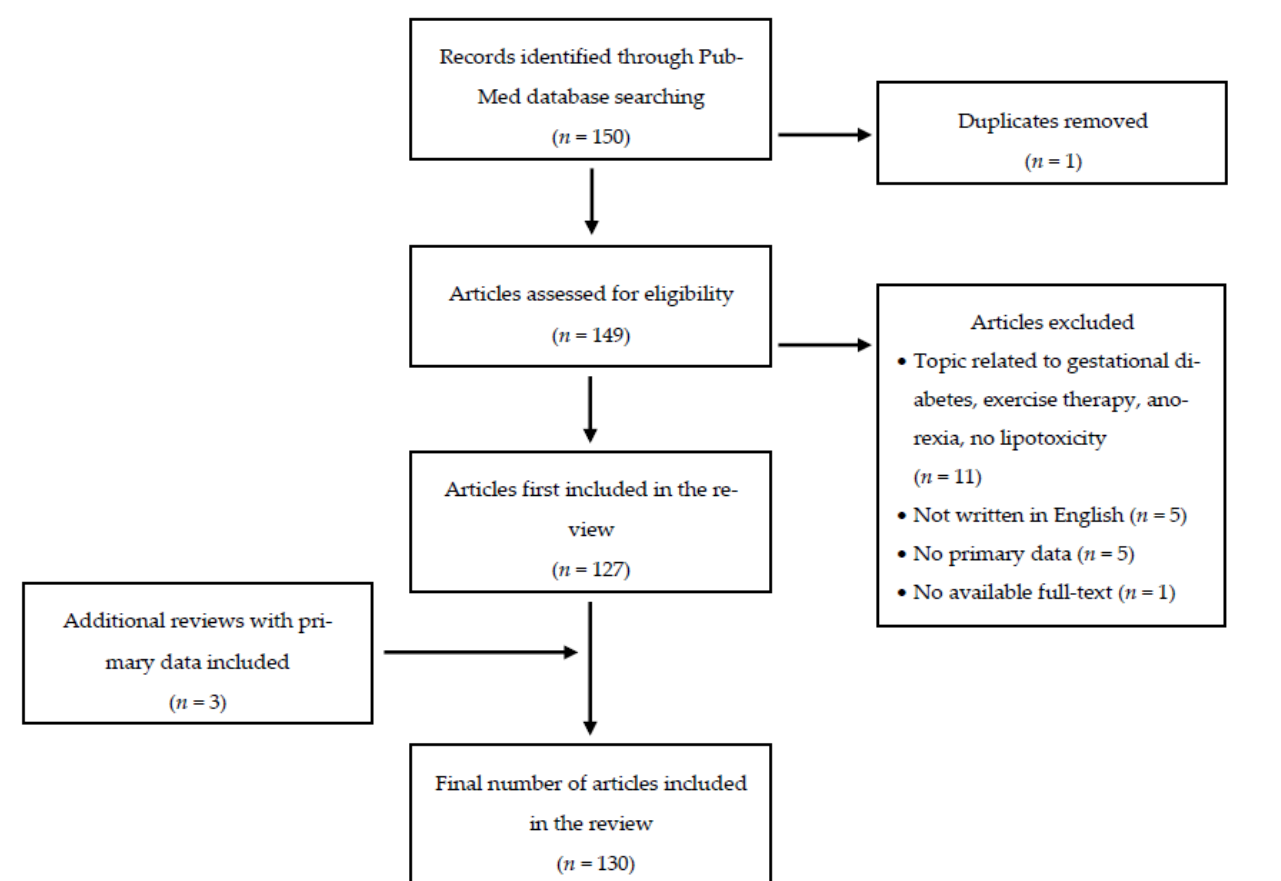
Figure 1. Flow diagram of the literature search on PubMed, www.ncbi.nlm.nih.gov/pubmed.